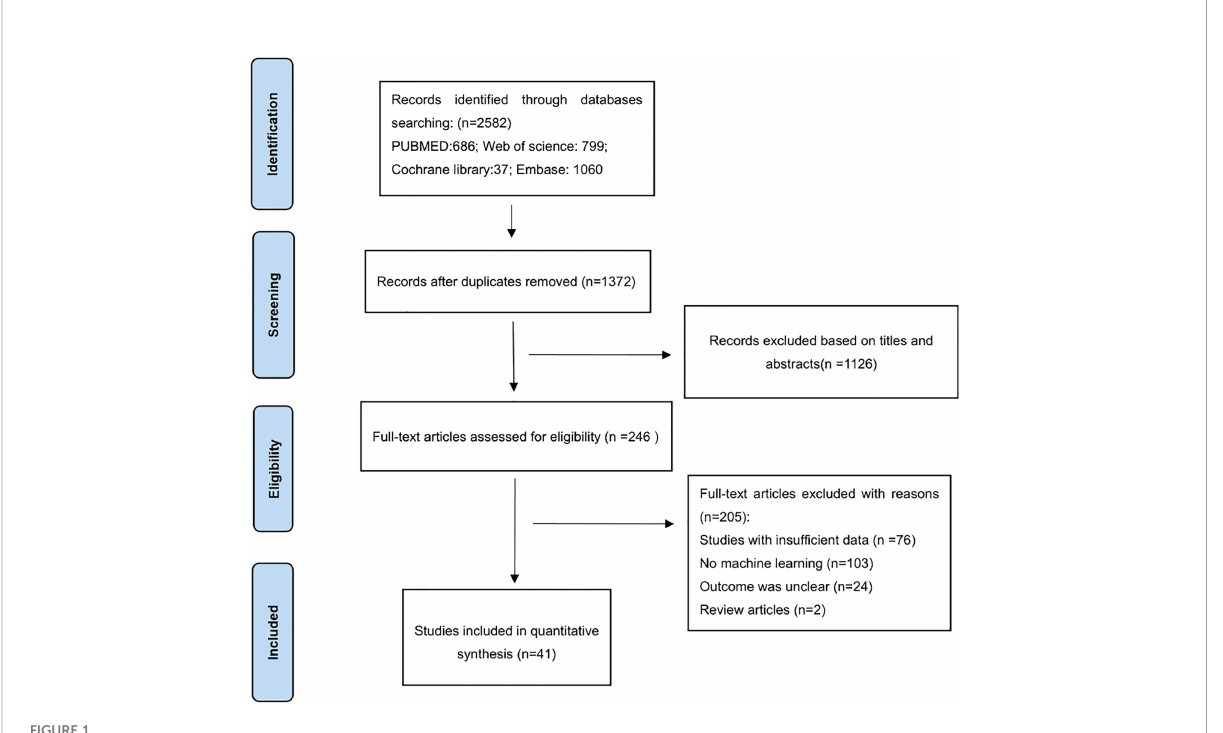
FIGURE 1 The PRISMA fl ow diagram for study